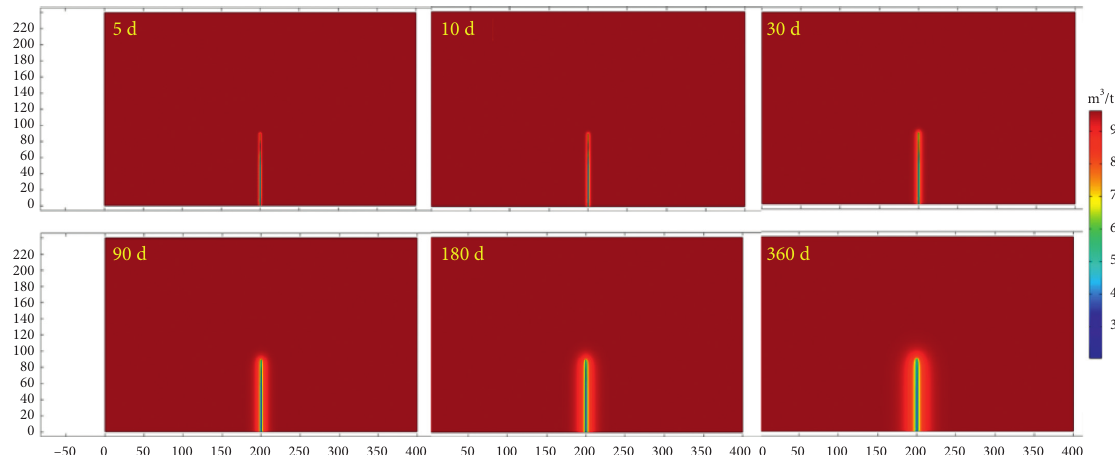
Figure 11: Cloud map of coal seam gas content distribution under different drainage time of 90-meter borehole.